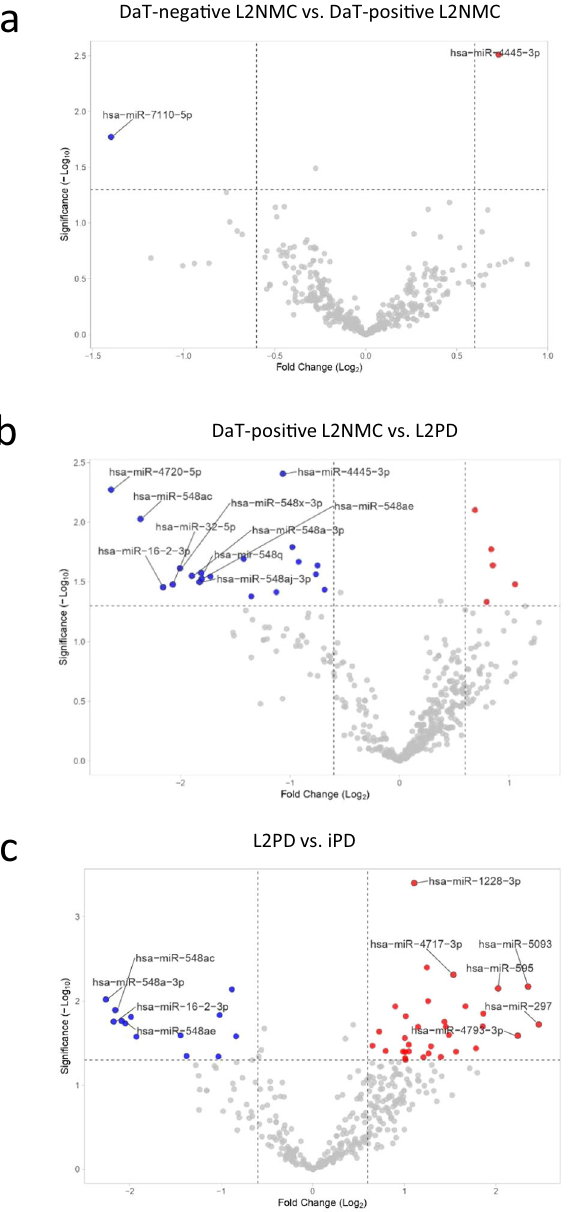
Fig. 4 Differential miRNA expression in successive G2019S LRRK2 progression stages and iPD. Volcano plots showing miRNA expression differences between a DaT-negative and DaT-positive L2NMC, b DaT-positive L2NMC and L2PD, and c L2PD and iPD patients. DEmiR were de fi ned as miRNAs with a fold-change above | 1.5| and a p value below 0.05 under a two-tailed Student ’ s t test. Only names of the top-10 miRNAs are shown. Up-regulated and down-regulated DEmiRs are respectively depicted in red and blue. DaT DaT-SPECT imaging, L2NMC LRRK2 non-manifesting carriers, L2PD LRRK2-associated PD patients, iPD idiopathic PD patients.